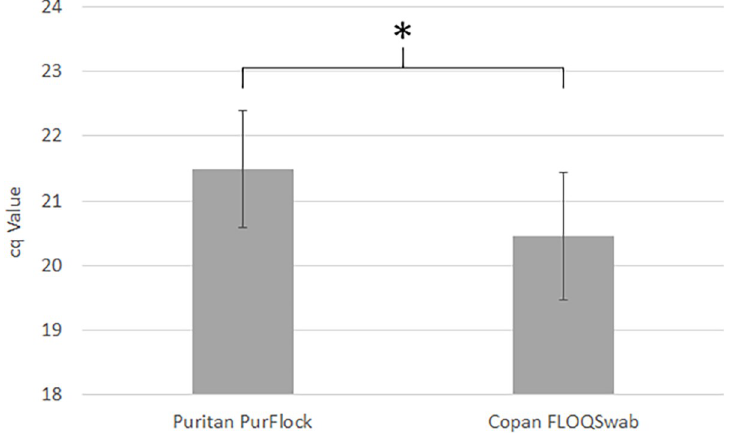
Fig 3. Comparison of total bacterial biomass collected from tongue dorsa by two swab products. Five samples were collected from 3 healthy volunteers using Puritan Purflock swabs or Copan FLOQSwabs. Bacterial biomass was quantified by qPCR using primers against a conserved bacterial rDNA locus. Bars represent mean Cq +/- standard deviation. Significance calculated using paired t-test (p = 0.0064).